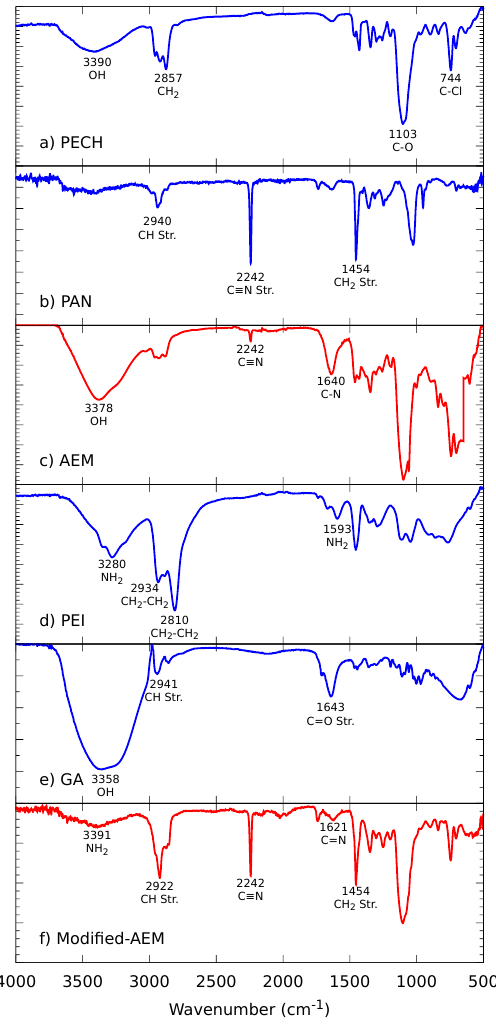
Figure 2. Fourier transform infrared (FTIR) spectra of the ( a ) polyepichlorohydrin (PECH) and ( b ) poly(acrylonitrile) (PAN) reagents, and the ( c ) synthesized anion exchange membrane (AEM), followed by the modified-AEM synthesized by solvent